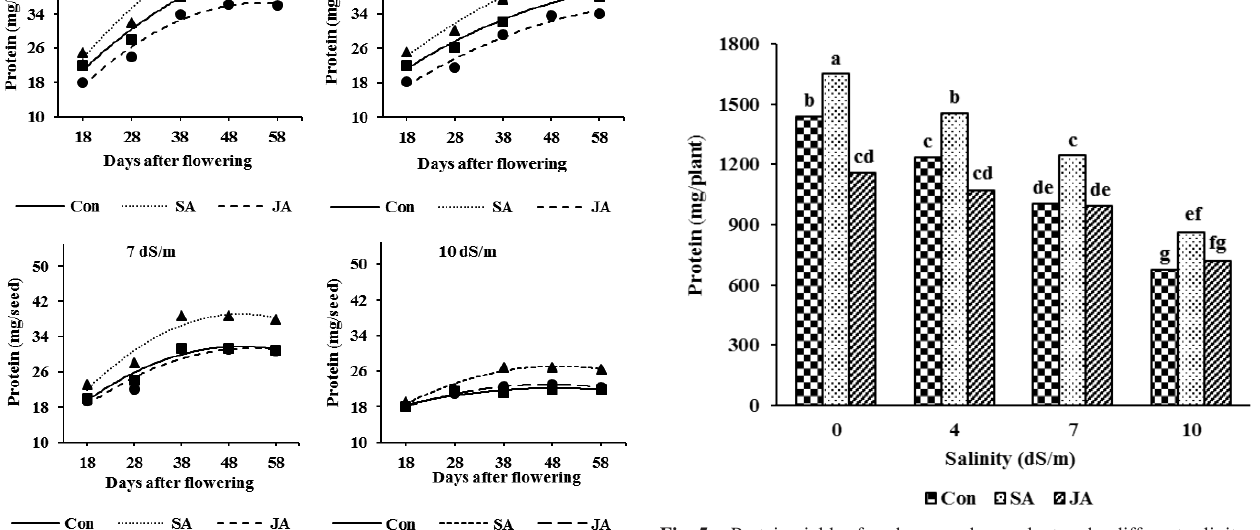
Fig. 4: Changes in protein content of soybean (M7 cultivar) seeds in re- sponse to salinity and hormonal applications